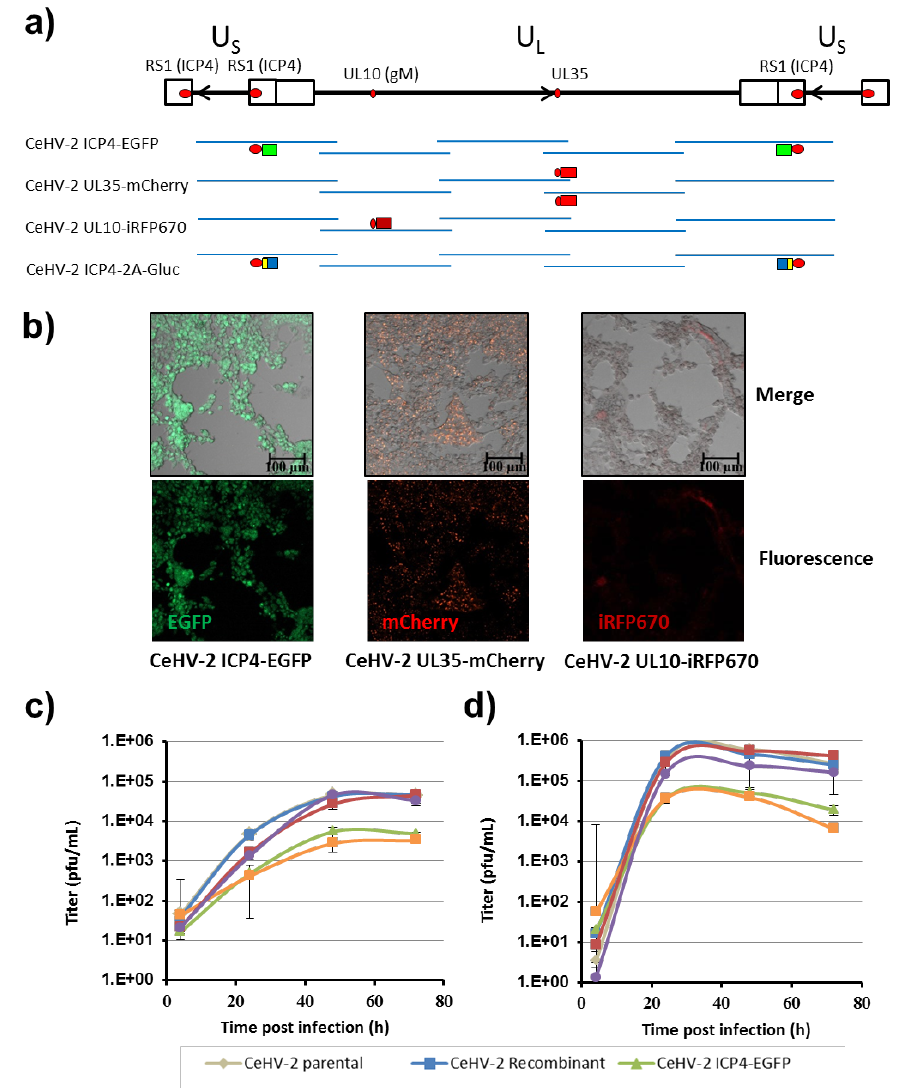
Figure 3. Generation and characterization of CeHV-2 reporter viruses. ( a ) Overview of modifications introduced into CeHV-2 fosmids. The genome of CeHV-2 is drawn, as in Figure 1b. The genes that were modified are indicated as red circles. Reporter genes coding for EGFP (green boxes), mCherry or iRFP670 (bright and dark red boxes) or 2A-Gluc (yellow and blue boxes) were inserted into the respective fosmids. In all cases, the reporter proteins were fused to the C-termini of the viral proteins. The names of the resulting CeHV-2 reporter viruses are indicated on the left side. ( b ) Rescue of CeHV-2 fluorescent reporter viruses. Vero76 cells were transfected with the wt and modified fosmids shown in (a) to generate CeHV-2 ICP4-EGFP (left), CeHV-2 UL35-mCherry (middle) or CeHV-2 UL10-iRFP670 (right). Plaque formation was monitored 6 d after transfection by confocal microscopy. Images show the respective fluorescent signal alone (fluorescence; lower panels) or in an overlay with a brightfield image (merge; upper panels). Scale bars represent 100 µ m. ( c , d ) Replication kinetics of parental and recombinant CeHV-2 viruses on Vero76 cells infected at MOI 1. Culture supernatant or cells were harvested at the indicated time points. Cells were subjected to three freeze-thaw cycles to release cell-associated virus. Titers were determined by plaque assay for viruses released into the supernatant ( c ) or for cell-associated viruses ( d ). The results of representative experiments, carried out with triplicate samples, are shown in panels c and d, and were confirmed in two separate experiments. Error bars indicate SD.